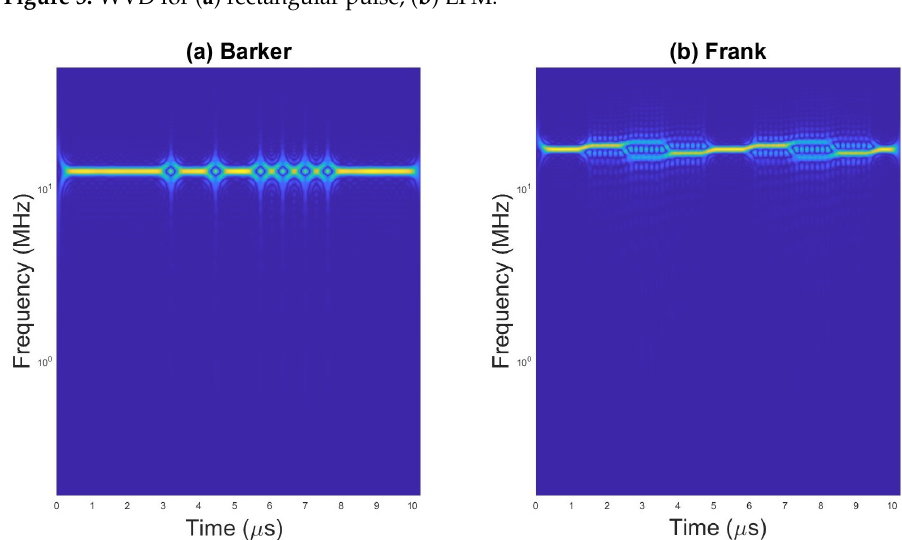
Figure 5. WVD for ( a ) rectangular pulse; ( b ) LFM.